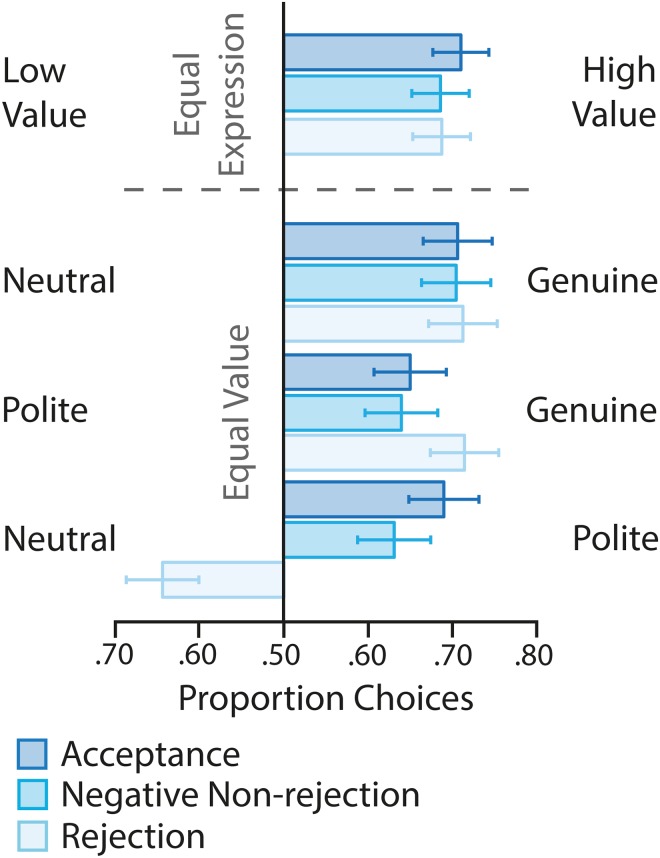
Choice behaviour.Average proportion choices allocated to stimuli in various pairings in the smile valuation task depending on value (holding expression constant) and expressive display (holding value constant) across feedback groups. Error bars show the 95%CIs.